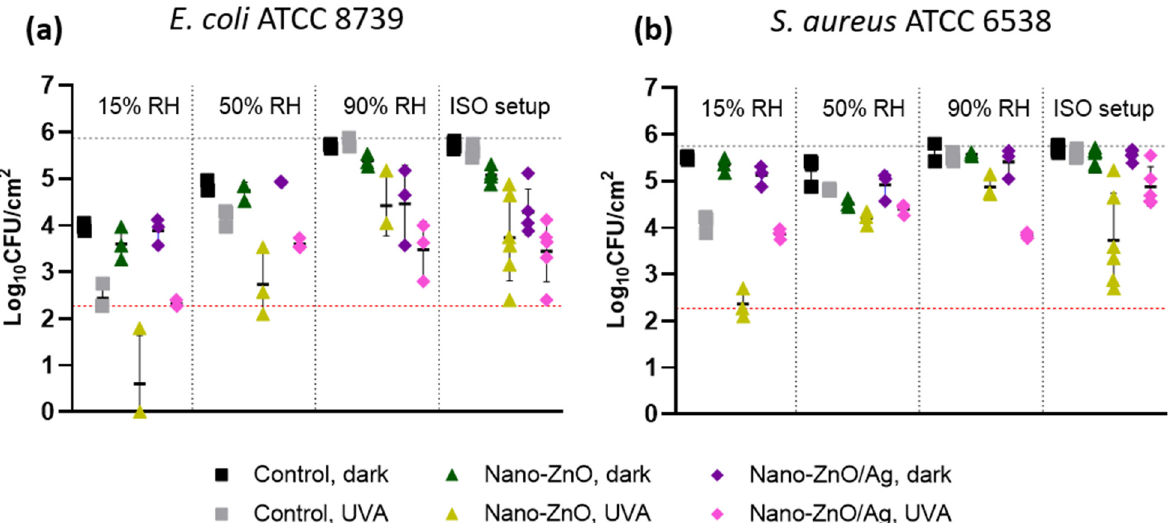
Figure 6. Antibacterial activity of surfaces based on matrix-embedded nano-ZnO or nano-ZnO/Ag towards E. coli ( a ) and S. aureus ( b ) in different relative air humidity (RH) conditions after 1 h. Nano-enabled surfaces generally demonstrate higher antibacterial ability at higher RH compared to the control surface in the same conditions; however, the effect of these surfaces is dependent on RH. Nano-Ag/ZnO surfaces lose their antibacterial activity at low RH in dark conditions (dark blue; a ). UVA exposure is more toxic to both bacteria at lower RH and E. coli is more sensitive to drying at lower RH. Mean value of at least 3 experiments ±SD is presented. Red dotted line denotes the practical limit of quantification with 3 colonies counted in undiluted samples.